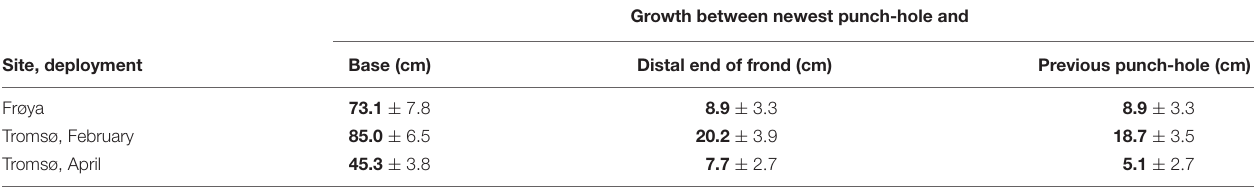
Growth between newest punch-hole and